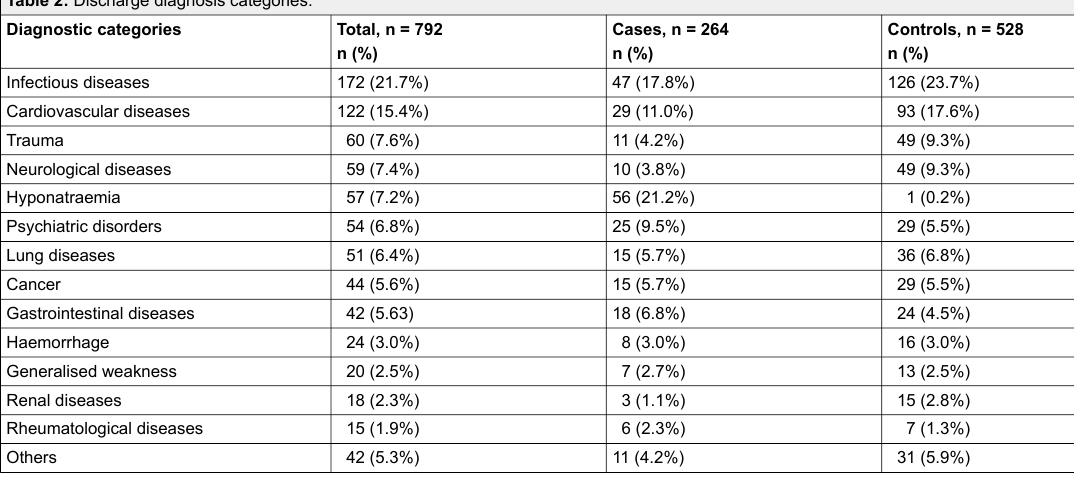
Table 2: Discharge diagnosis categories.